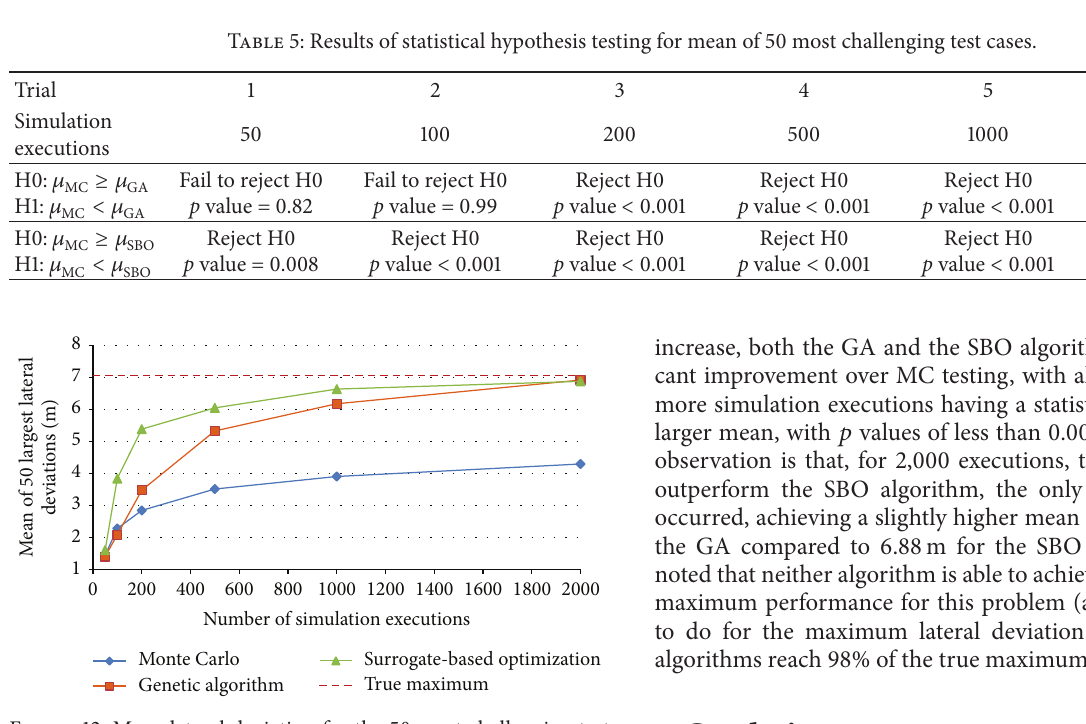
Figure 12: Mean lateral deviation for the 50 most challenging test cases as a function of allowable simulation